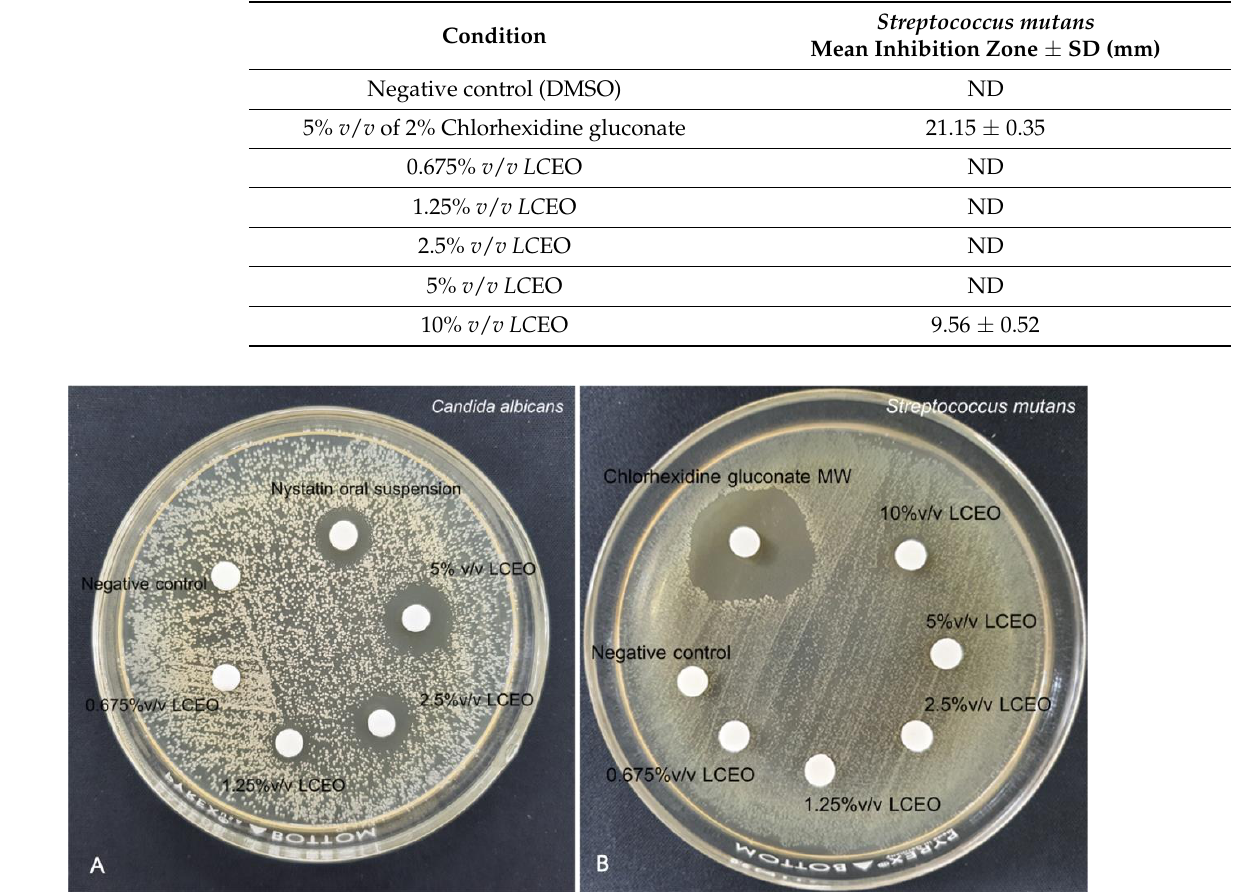
Figure 1. Agar disc diffusion assay of various concentrations of LCEO, positive controls (5% v / v of 2% chlorhexidine gluconate mouthwash and nystatin oral suspension) and negative control (DMSO) against C. albicans ( A ) and S. mutans ( B ). Table 2. Mean inhibition zone ± SD ( n = 5) of different concentrations of LC EO against C. albicans. Inhibition zone less than 6 mm was defined as not detected (ND).